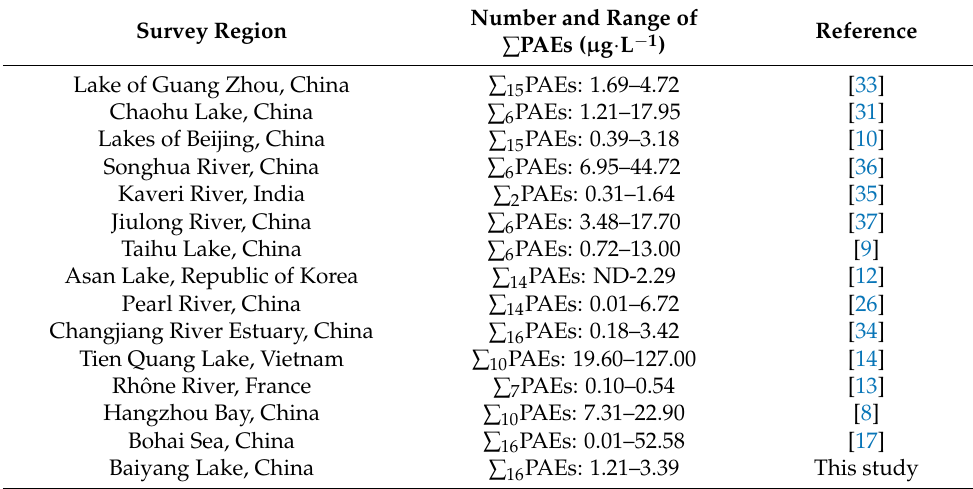
Table 2. Comparison of the PAE concentrations with other areas in the world. Survey Region